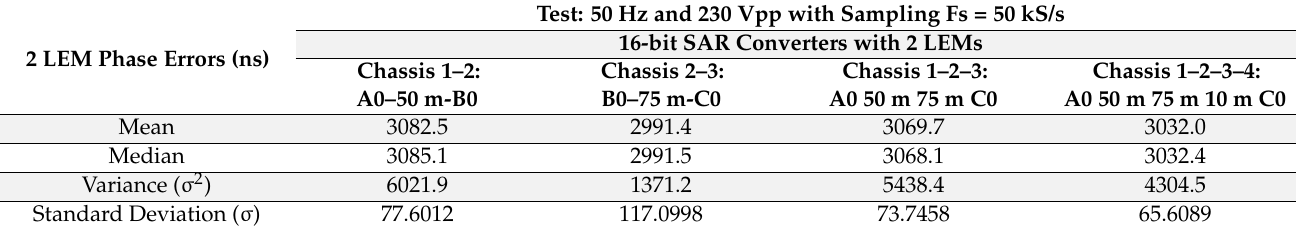
Table 7. Phase errors for SAR converters. Tests with two LV-25 LEMs.